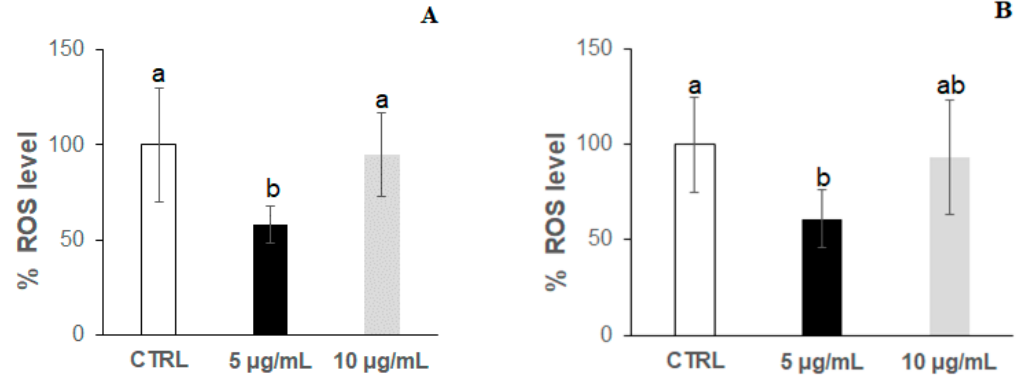
Figure 4. Percentages of worm survival at the 9th day of adulthood after the application of thermal stress (35 ◦ C, 8 h). The results were obtained in the C. elegans wild-type N2 strain grown in the absence (controls) and presence of the bilberry anthocyanin extract at concentrations of 5 and 10 µ g / mL in the culture medium. The results are presented as the mean values ± SD. Di ff erent letters between bars indicate significant di ff erences, p < 0.05.